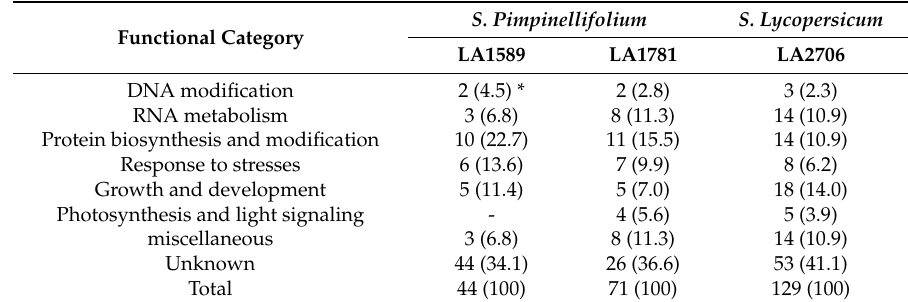
Table 2. Functional categories of genes showing differential splicing in response to changing growth